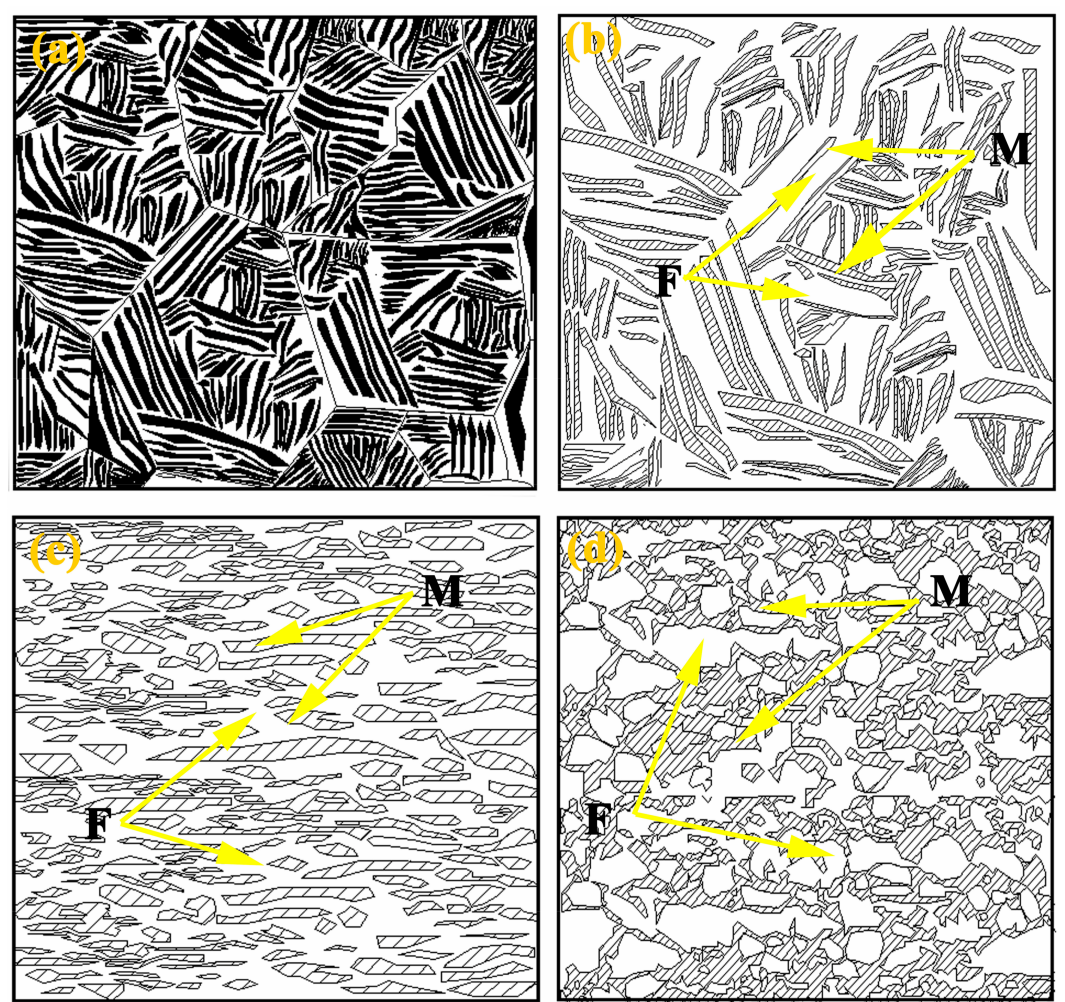
Figure 6. Schematic representation of prevailing microstructure evalution during processing. ( a ) martensitic microstructures; ( b ) fibrous DP microstructures; ( c ) cold rolled fibrous DP microstructures; and ( d ) UFG DP